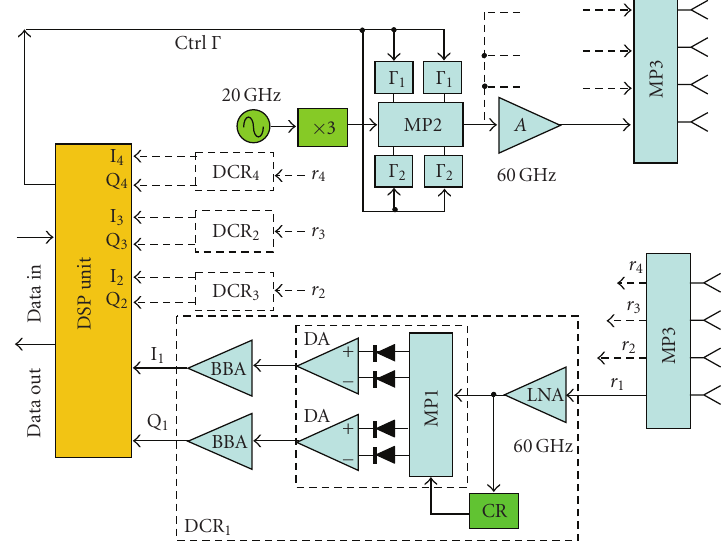
Figure 5: The simplified block diagram of a multiport direct conversion